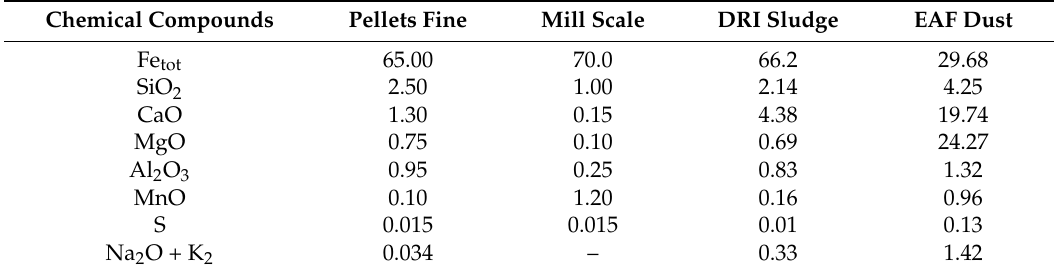
Figure 2. Particle size distribution of the briquetted charge. Lower—original mix; upper—after grinding. Chemical composition of the mix components is given in Table 1. Table 1. Chemical composition of the mix components.